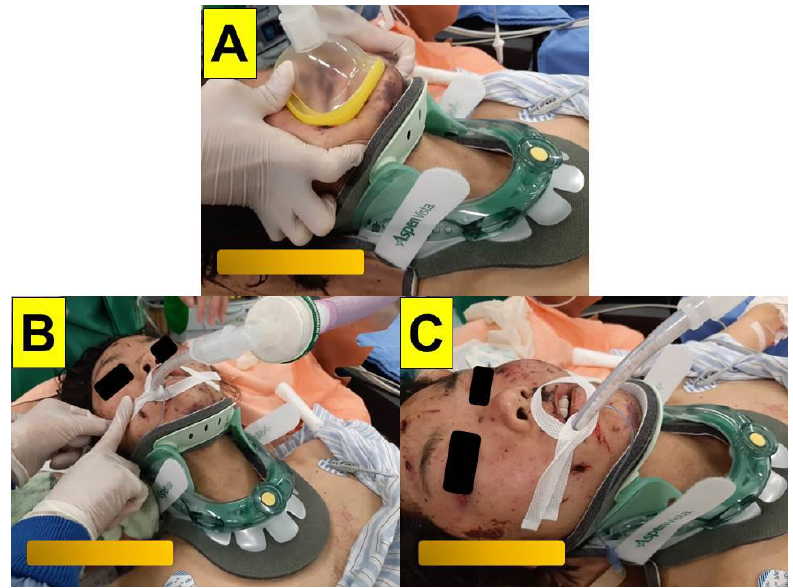
Figure 2. (Case 1) A 30-year-old woman with multiple trauma for emergency surgery. A rigid cer- vical collar was applied before the induction of anesthesia. ( A ) Face mask ventilation, ( B , C ) airway